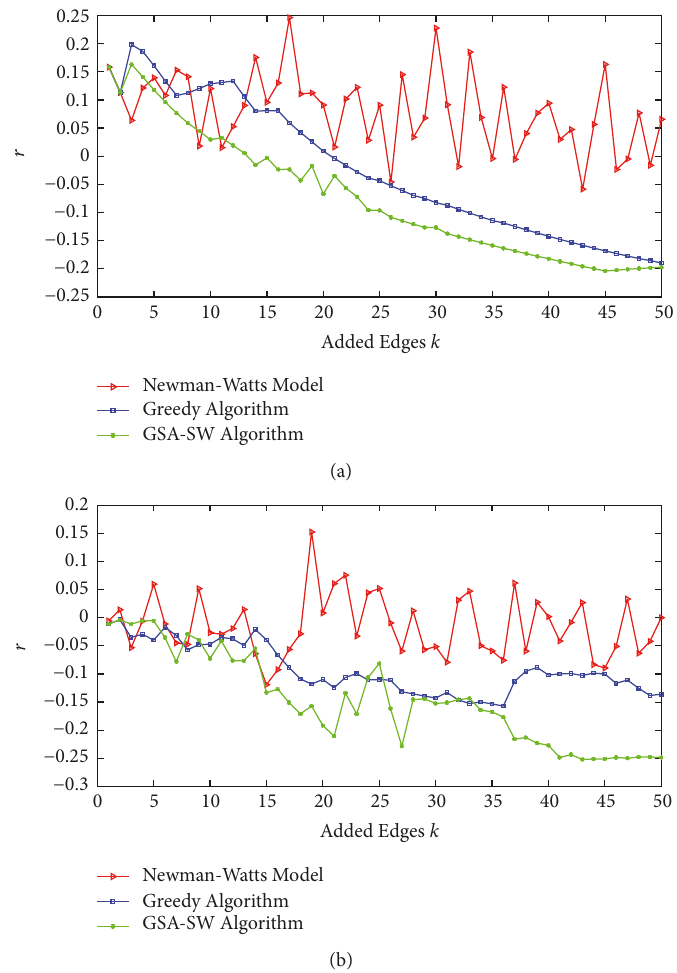
Figure 8: Assortativity coefficient r for three algorithms. (a) Results for the regular network. (b) Results for the random network.